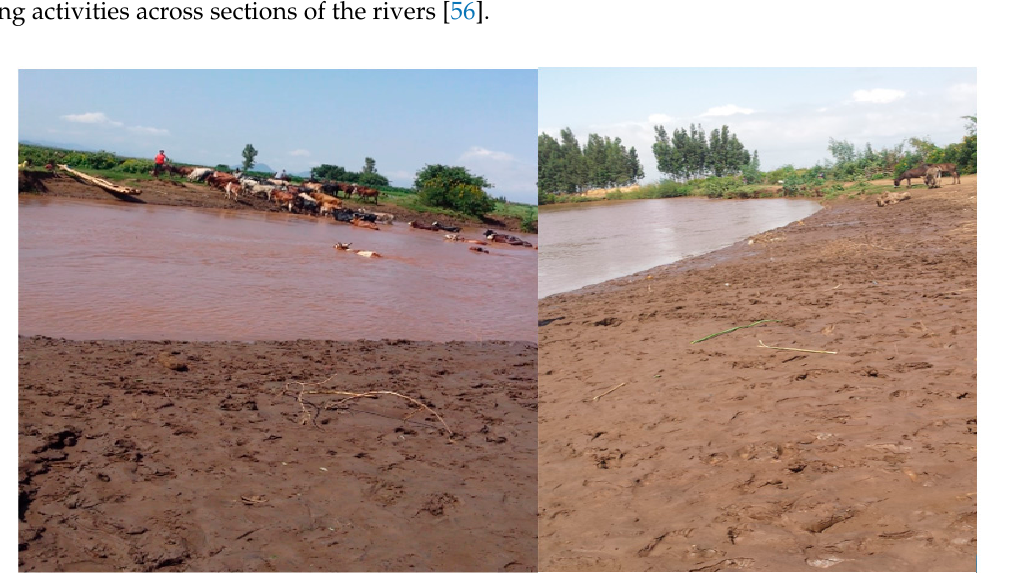
Figure 5. Floodplain area of the lower Maki River.